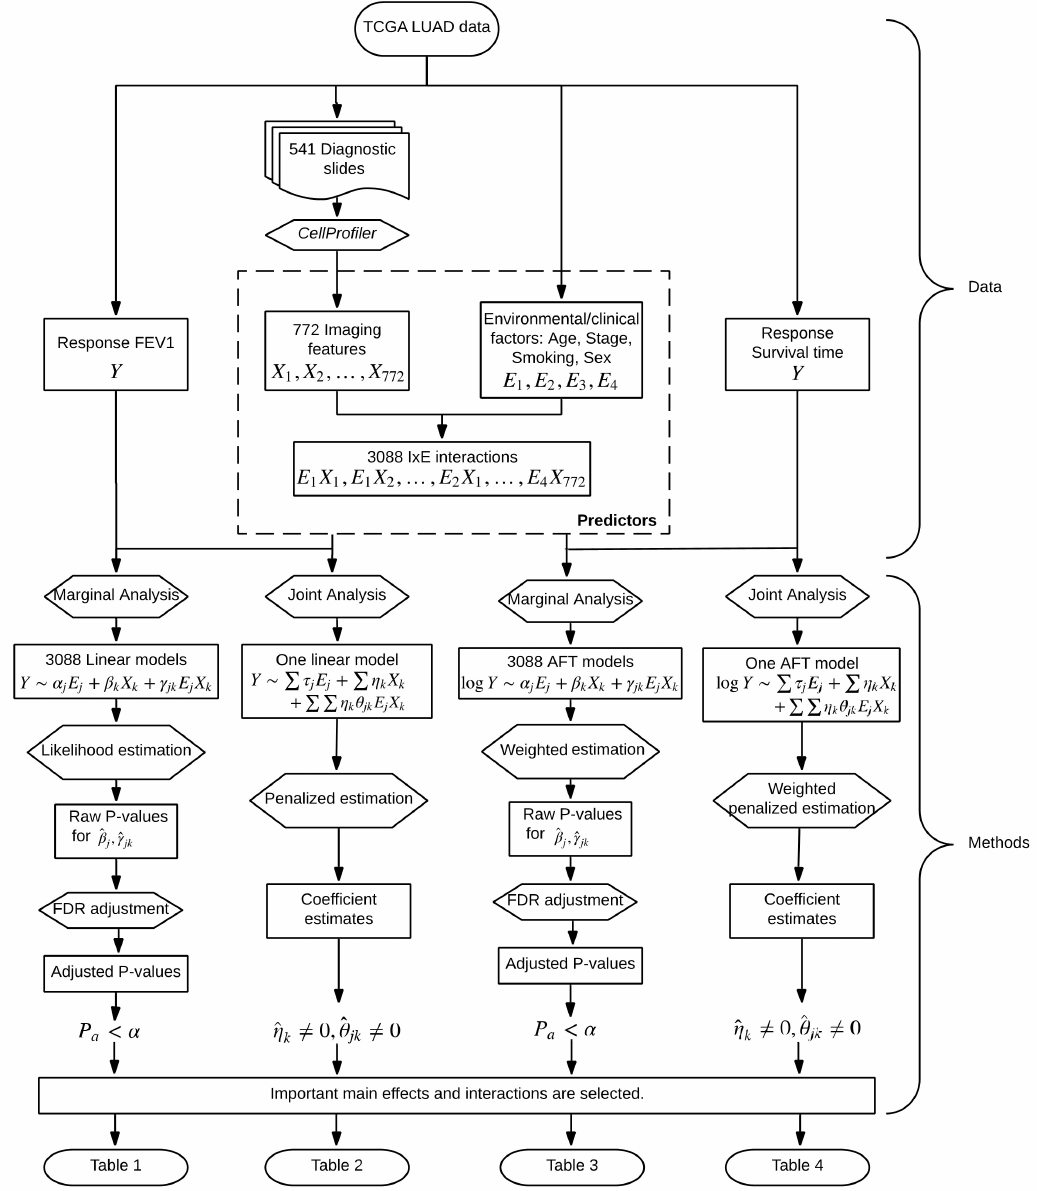
Figure 1. Flowchart of the I–E interaction analysis of The Cancer Genome Atlas (TCGA) lung adenocarcinoma (LUAD)